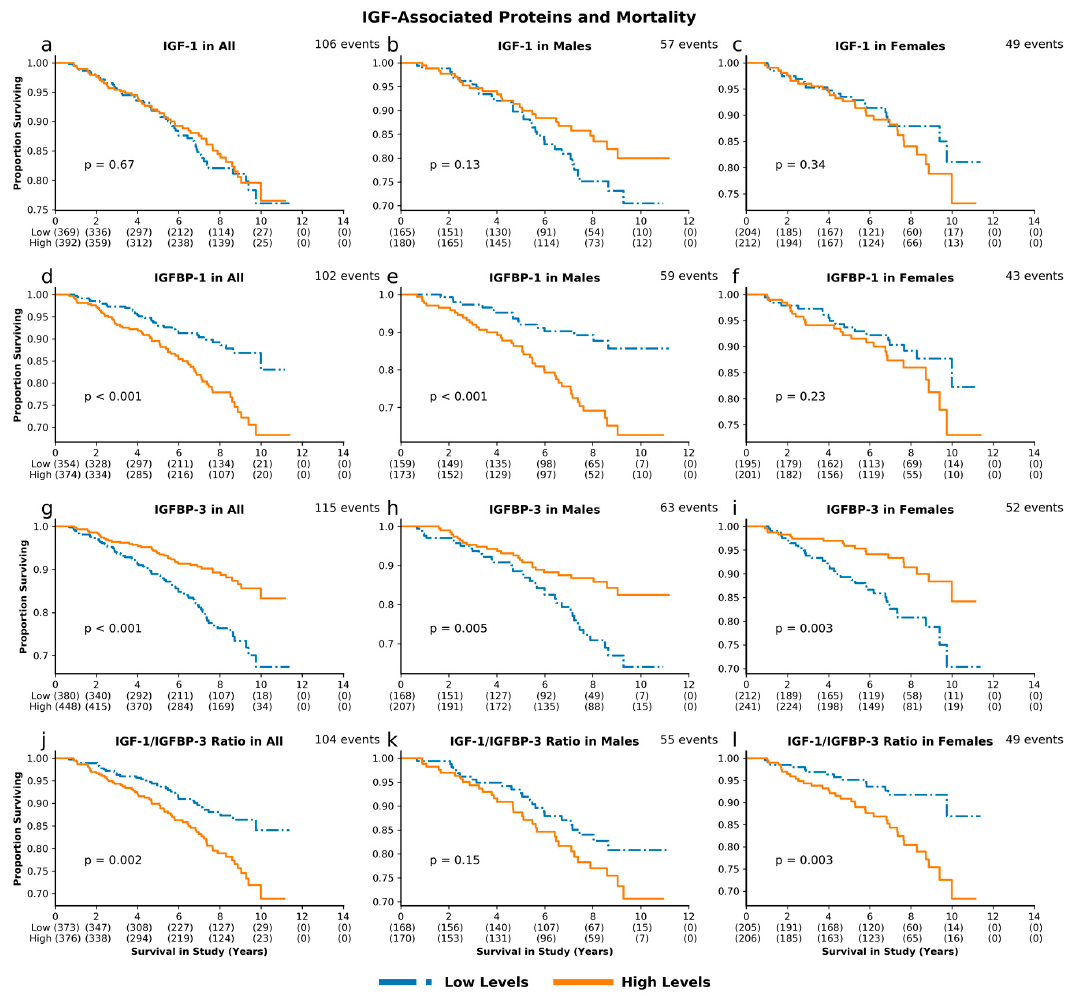
Figure 1. Insulin-like growth factor (IGF)-associated proteins and mortality. Unadjusted survival curves for individuals with high and low levels of IGF-1 ( a . combined cohort; b . males; c . females), IGFBP-1 ( d – f ), IGFBP-3 ( g – i ), and IGF-1 / IGFBP-3 molar ratio ( j – l